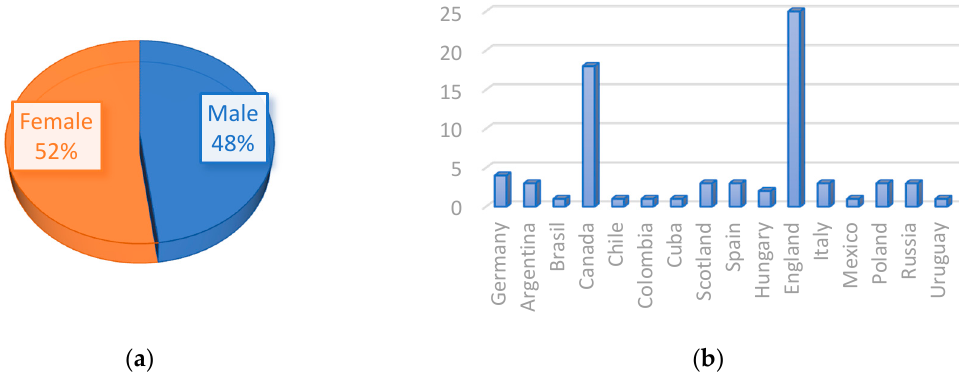
Figure 2. Distribution of clients responding the survey: ( a ) By sex; ( b ) By country.